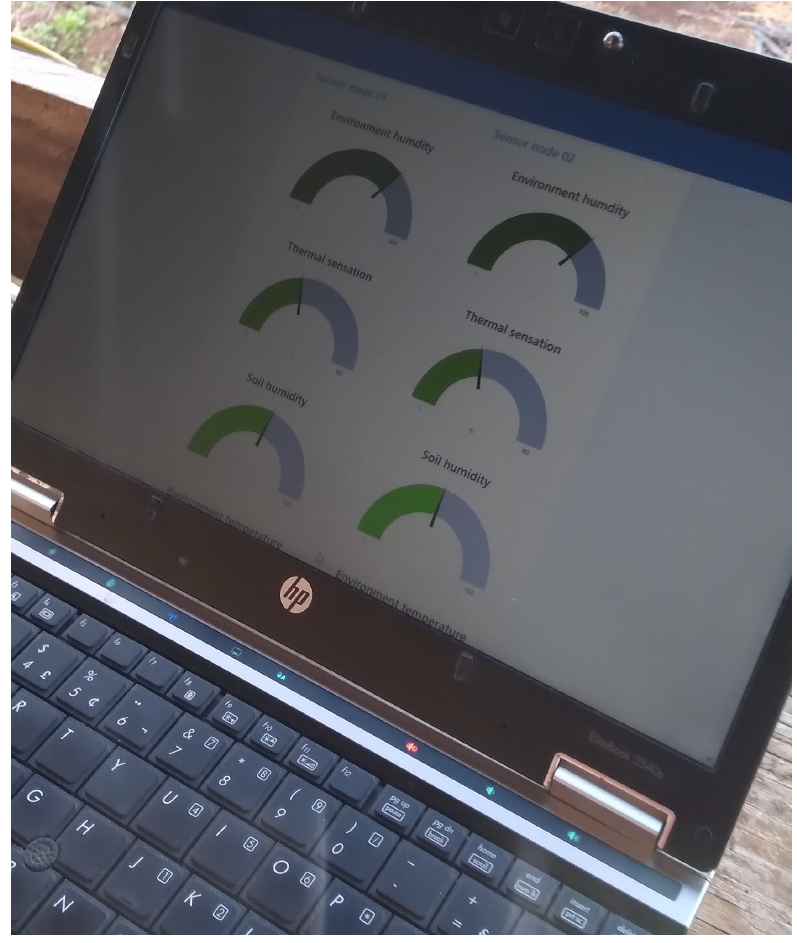
Figure 17. Offline dashboard applied on NodeRed.